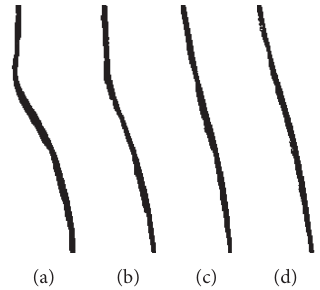
Figure 6: Binary image of crack propagation path. (a) S